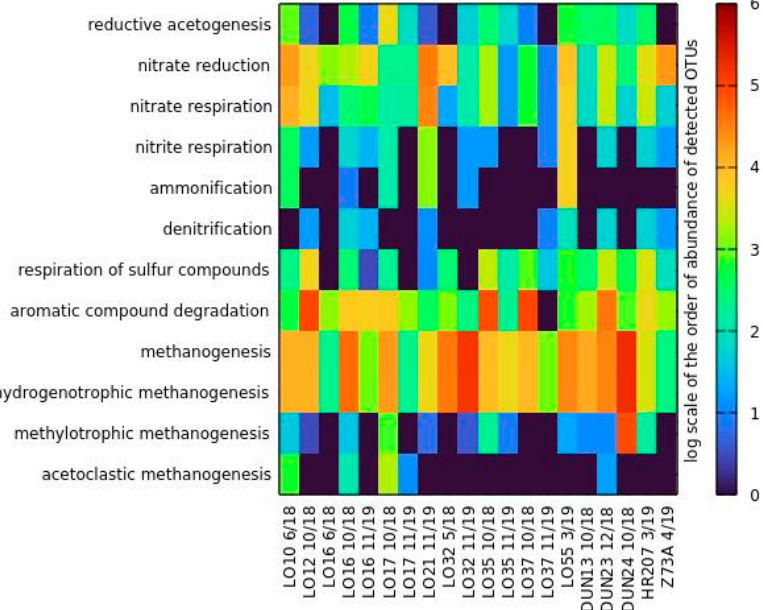
Figure 4. Selected metabolic groups predicted using the database of functional annotations of prokaryotic organisms, FAPROTAX.